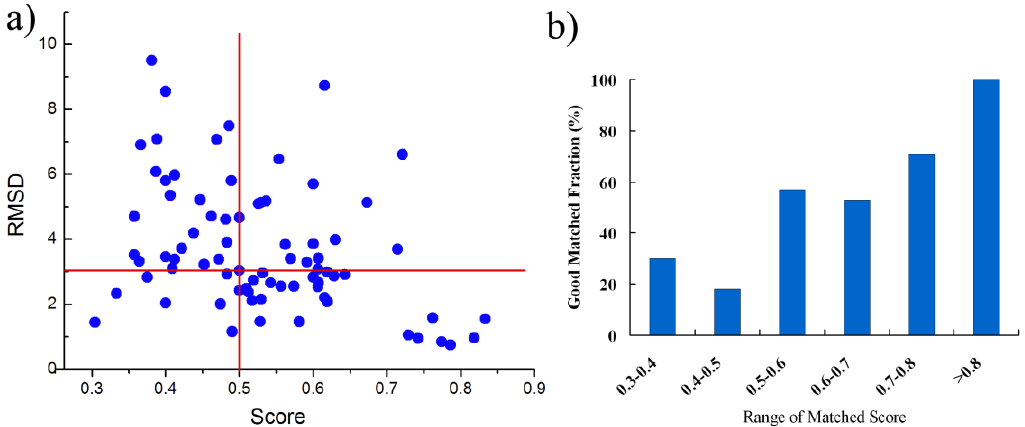
Figure 4. The summary of the matched results of BSMM for data set B: given the good matching should be RMSD < 3 Å , the rate of good matching for data set B is 44%; for Mscore > 0.5, the rate of good matching for data set B is 60%; the rate of good matching does not correlate to the sequence identity when the sequence identity < 12%. ( a ) the correlation between the ligand RMSD and the the matched score; ( b ) the good matching rate in di ff erent range of matched